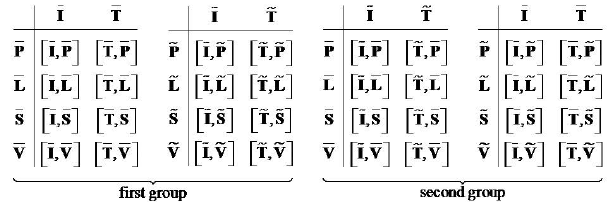
Figure 1: Classification of the space and time elements related to the physical